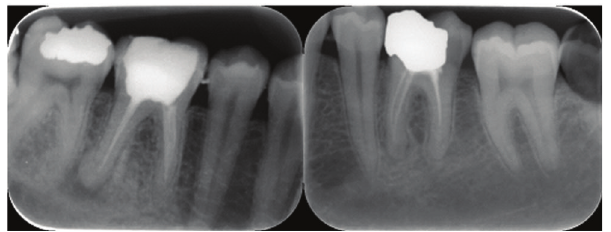
Figure 12: Teeth with gutta-percha more than 2 mm short of the radiographic apex